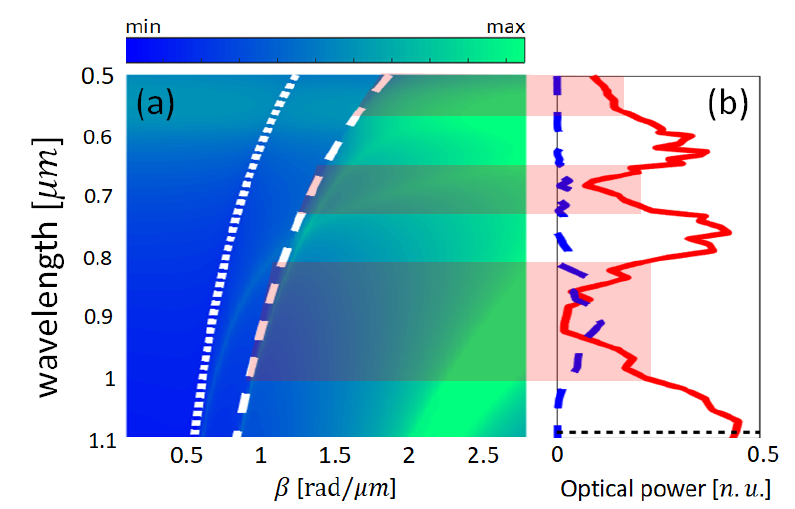
Figure 4. ( a ) Dispersion curves for a HMM of 6 Au and 6 TiO 2 layers with a filling fraction p = 0.5 and period T = 80 nm. Dotted and dashed curves represent air and glass light-lines, respectively. ( b ) Normalized transmission (red solid) and reflection (blue dashed) spectra (normalized units) for an integrated system with a finite HMM ( N = 12, p = 0.5, and T = 80 nm) integrated on top of a dielectric waveguide. Several modes in the dispersion curves are associated in the main bands corresponding to the broad-band minima in the normalized transmission spectrum (shaded